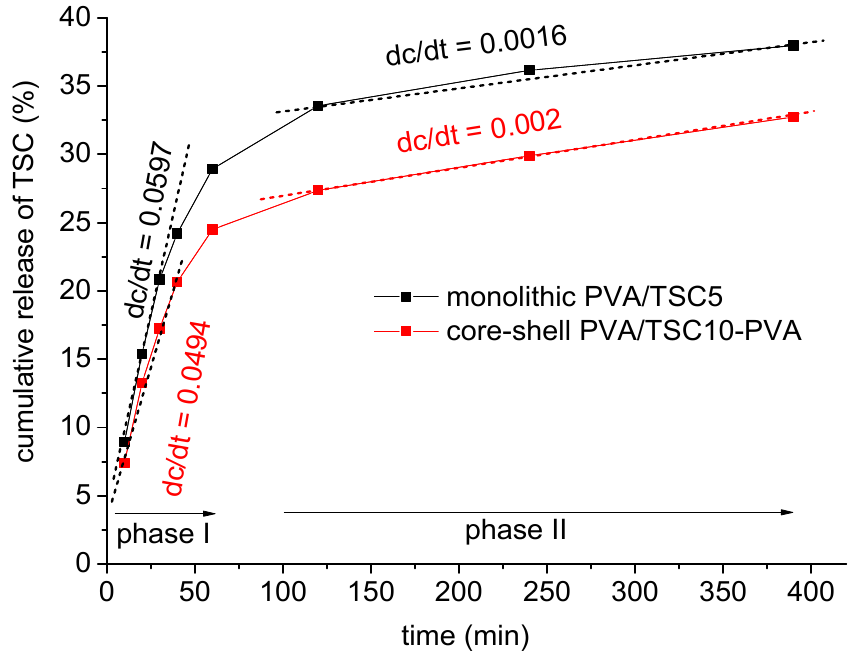
Figure 6. Cumulative release percentage of HapyTSCmB from the monolithic PVA / TSC5 and core–shell PVA / TSC10-PVA fiber mats over a period of 390 min.